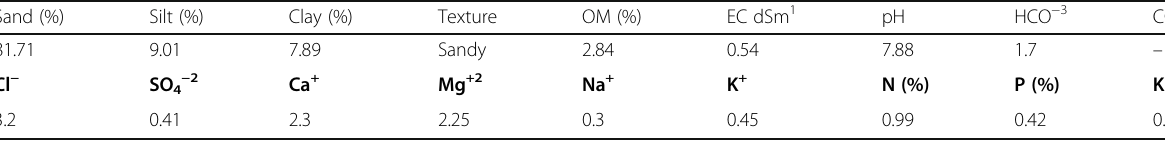
Table 1 Physical and chemical properties of the experimental soil Sand (%) Silt (%) Clay (%)